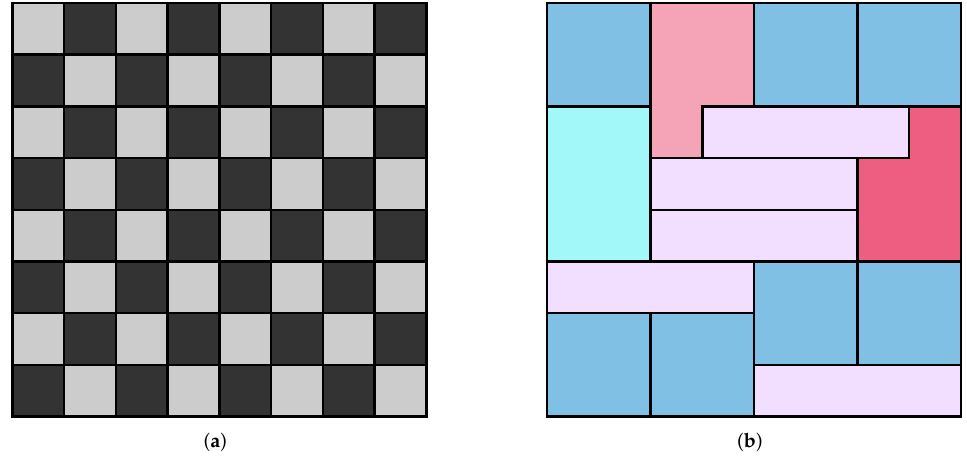
Figure 24. Target region and a tiling solution for Example 12: ( a ) the target region (cid:98) R , a checkerboard coloured 8 × 8 square; ( b ) successful tiling of the target region (cid:98) R using five copies of the straight tetromino, seven copies of the 2 × 2 square, one copy of the 2 × 3 rectangle, and two copies of the P-shaped pentomino. The single optimal solution uses five copies of P + (= P − ), one copy of P + (= P − ), and one copy each of P + 2 3 3 are coloured violet, blue, light blue, red, and light red, and P − 4